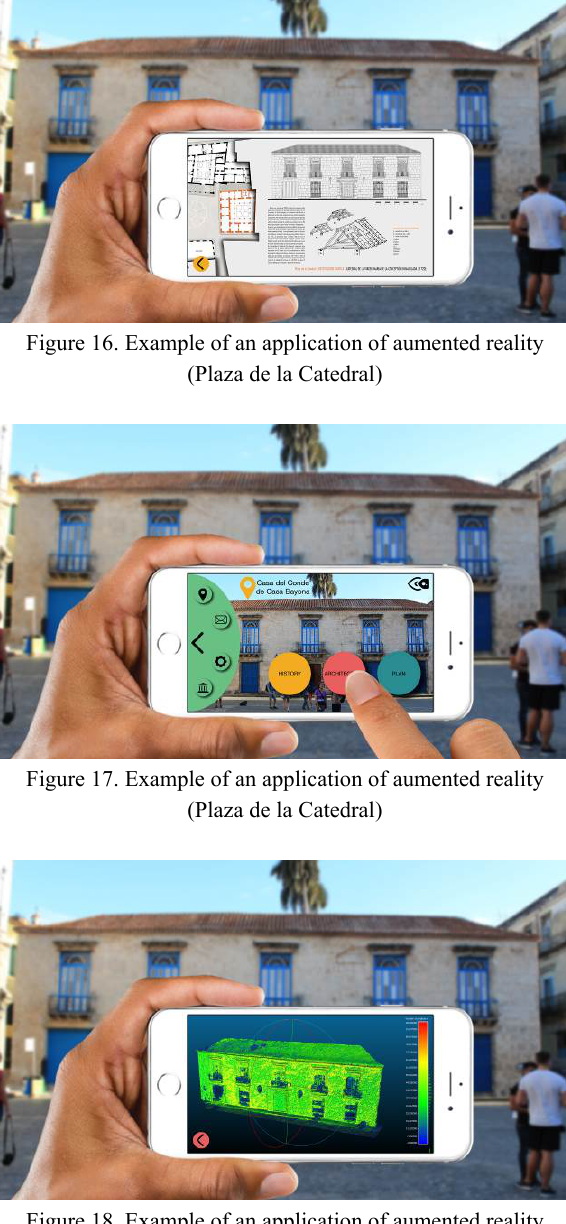
Figure 18. Example of an application of aumented reality (Plaza de la